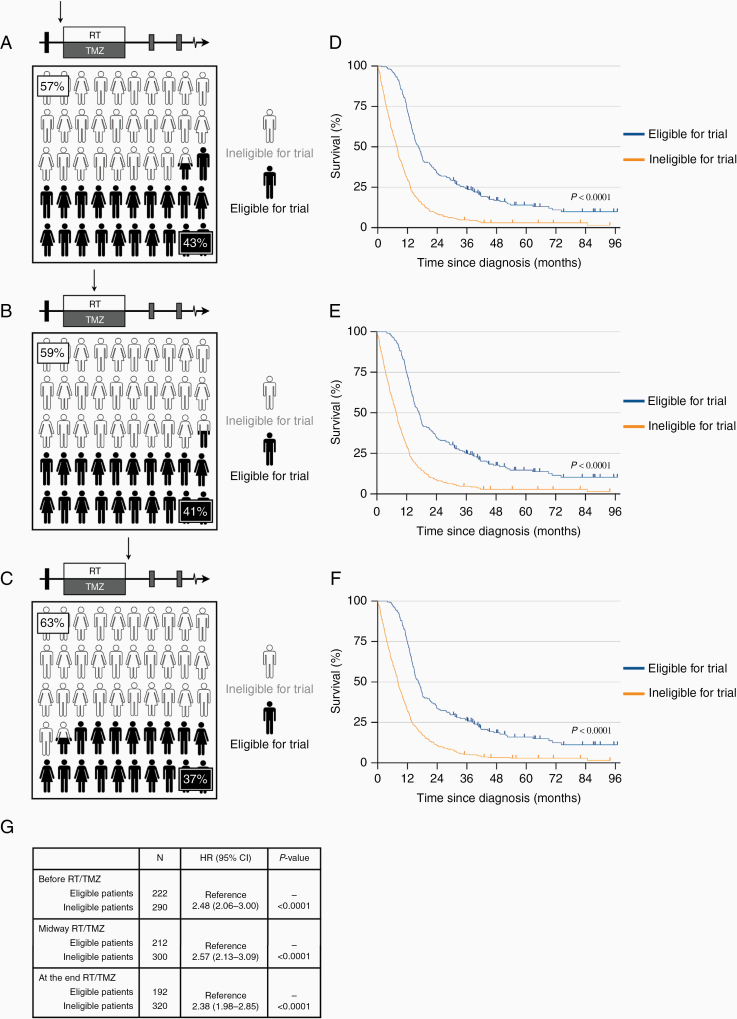
Simulated study group derived from a GBM population. (A) When filtering patients according to the selected study criteria, 57% of patients were considered ineligible for a clinical trial before the concurrent RT/TMZ. (B) Midway through RT/TMZ, the filtering excluded 59% of the patients, and (C) 63% of the patients were considered ineligible at the end of concurrent RT/TMZ. (D–F) Survival curves of patients found eligible compared to those found ineligible. There was a significant survival advantage (P < .0001) with over 2 times increased median, 2-y and 5-y survival at all time points for the patients found eligible for trials. (G) Hazard ratios of death of the patients found ineligible compared to those found eligible. RT, radiotherapy; TMZ, temozolomide.